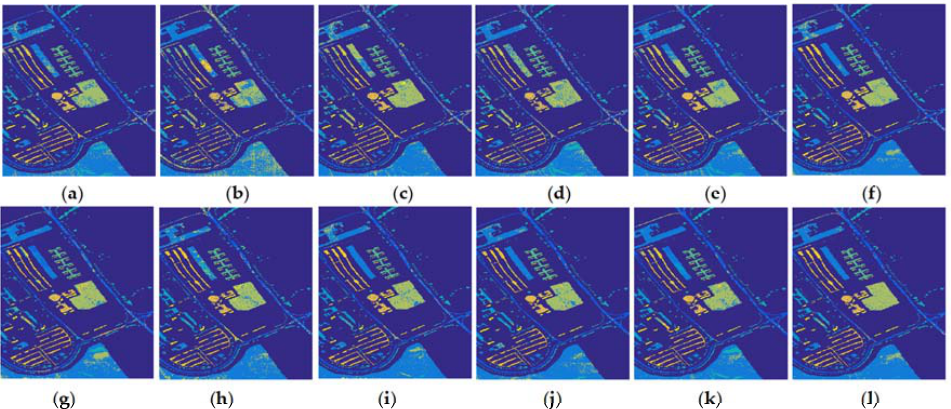
Figure 7. Results in Pavia University dataset (40 training samples per class): ( a ) K-SVM (spectral; OA = 83.58); ( b ) SMLR (spectral; OA = 70.74); ( c ) K-SMLR (spectral; OA = 83.22); ( d ) ESMLR (spectral; OA = 78.41); ( e ) K-ESMLR (spectral; OA = 83.47); ( f ) K-SVM (EMPAs; OA = 90.07); ( g ) SMLR (EMAPs; OA = 85.64); ( h ) K-SMLR (EMAPs; OA = 87.90); ( i ) ESMLR (EMAPs; OA = 91.24); ( j ) K-ESMLR (EMAPs; OA = 90.17); ( k ) SMLR (proposed linear MFL; OA = 89.07); ( l ) ESMLR (proposed linear MFL; OA =